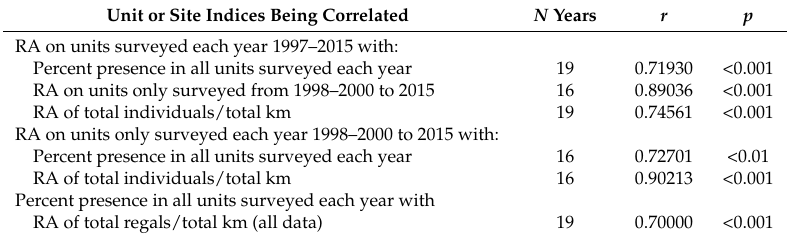
Table 6. Pairwise Spearman rank correlations of different measures of Regal fritillary incidence and abundance at Buena Vista Grassland, at the scale of the entire site complex. In the correlations of relative abundance (RA) between long-term monitoring units and total individuals/total km, we excluded from this latter measure the data in the long-term time series it was being compared to.